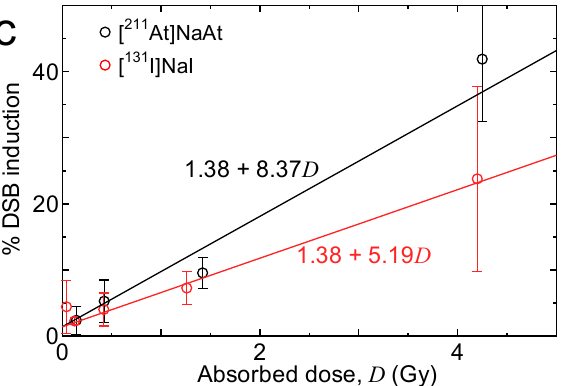
Figure 1. ( a ) Stained images of K1-NIS cells treated with the [ 211 At]NaAt solution and [ 131 I]NaI solution. Cell nuclei were stained blue and double-stranded break (DSB) induction signals were stained pink. ( b ) The percentage of DSB induction by [ 211 At]NaAt and [ 131 I]NaI. Percentage of DSB induction (DSBs%) was calculated using the formula: area of DNA damage (pink area)/nuclear morphology (pink area + blue area) × 100. ( c ) Relationship between %DSB induction and absorbed dose. The results of linear fitting of the experimental data are also shown in the figure.